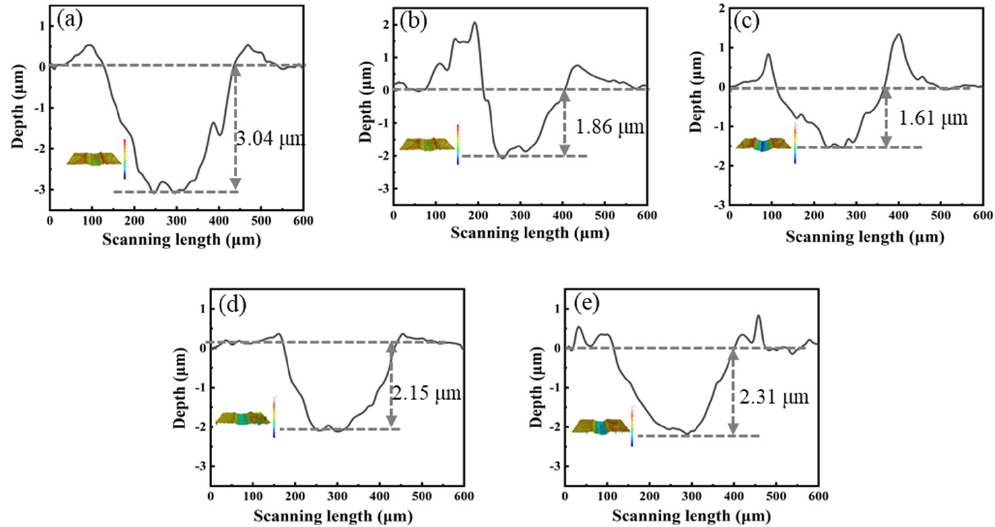
Figure 13. The cross-section profiles and three-dimensional (3D) micrographs (inserted pictures) of the worn track of UHMWPE substrates treated with different carbon plasma currents under artificial seawater friction: ( a ) original UHMWPE, ( b ) 0.5 A, ( c ) 1.0 A, ( d ) 1.5 A, ( e ) 2.0 A.